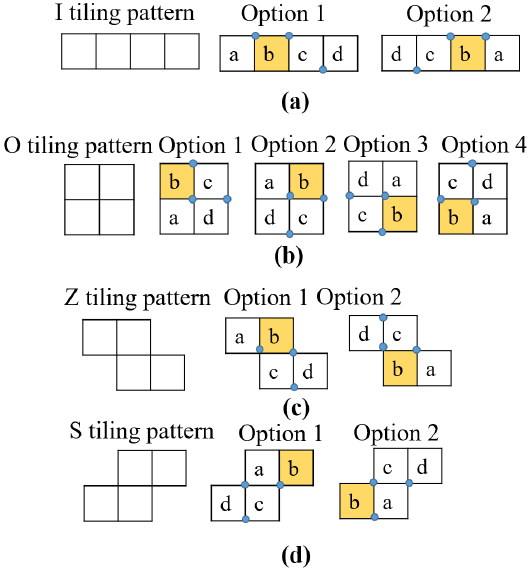
Figure 8. The tiling pattern and corresponding other blocks’ locations considering block b as a reference point for hTetro symmetrical morphologies. ( a ) I shape; ( b ) O shape; ( c ) Z shape; ( d ) S shape.